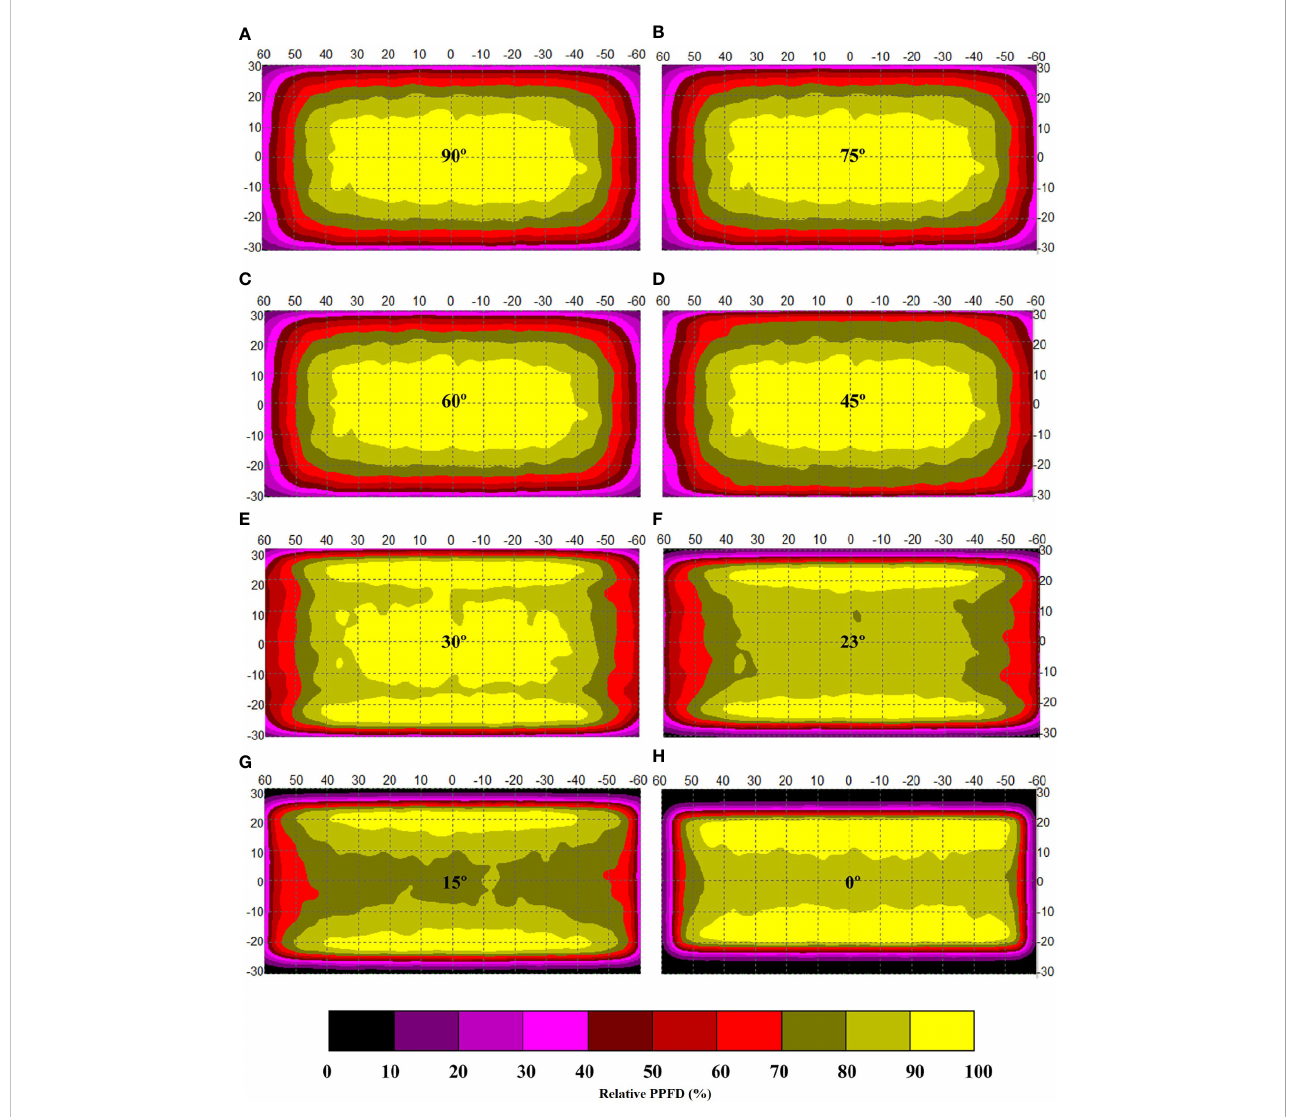
FIGURE 3 Sketchy screening of the appropriate included angles for the optimization of simulated light intensity distribution along an indoor farm rack shelf with the application of an adjustable lampshade-type re fl ector. Speci fi cally, the screened included angles are (A) 90°, (B) 75°, (C) 60°, (D) 45°, (E) 30°, (F) 23°, (G) 15°, and (H) 0°, respectively. The width of the re fl ective board is set as 10 cm. The scale unit on the fi gures is centimeter. The numbers in the color bar indicate relative photosynthetic photon fl ux density values